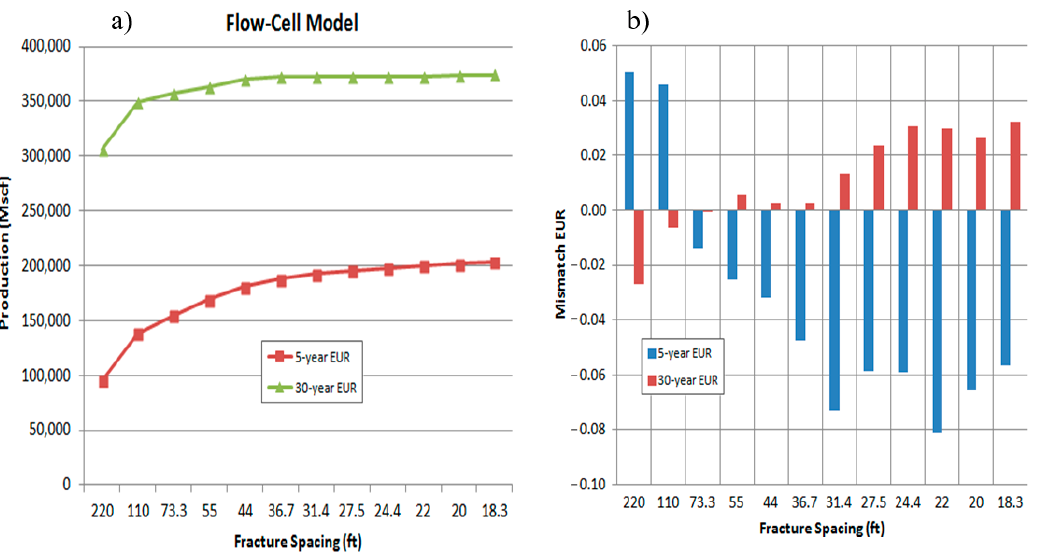
Figure 11. ( a ) Flow-cell model forecasts for 5-year and 30-year EUR (Mscf), due to fracture spacing changes between 220 and 18.3 ft. ( b ) Mismatch ∆ of flow-cell based 5-year and 30-year EURs (Table 4) and those produced with the ResFrac simulator (Table 2a).